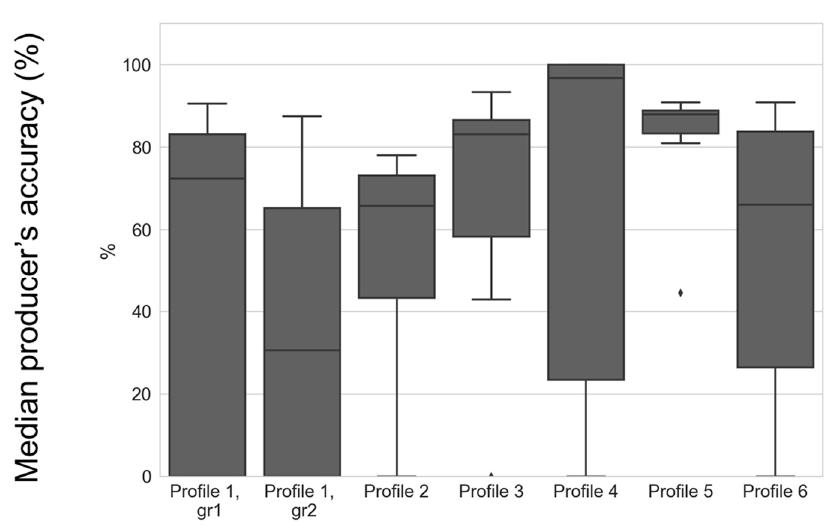
Figure 16. Boxplots showing the median values of producer’s accuracies by user profile.